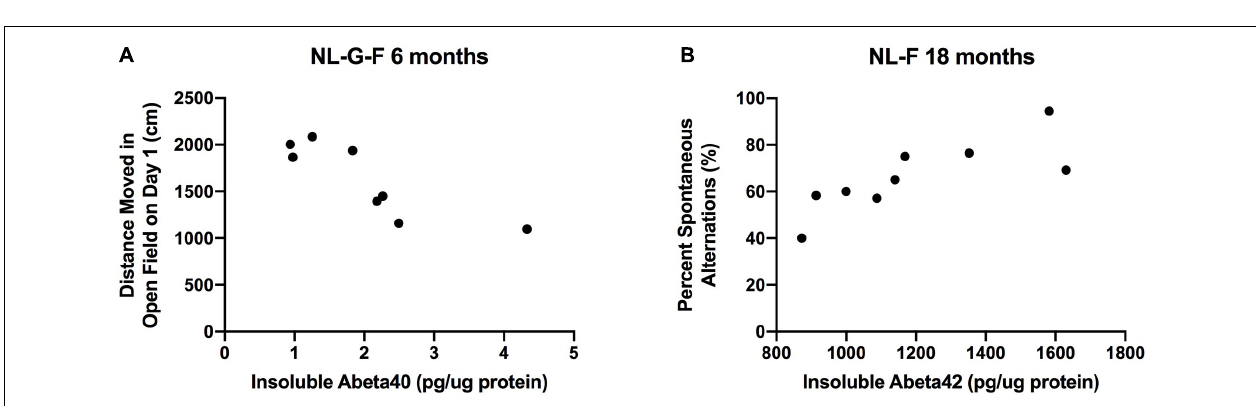
FIGURE 15 | (A) At 6 months of age, insoluble cortical A β levels were negatively correlated with activity levels on the first day of open field testing ( r = –0.8494, p = 0.0076, n = 8 XY pairs). (B) At 18 months of age, insoluble cortical A β 42 levels were positively correlated with percent spontaneous alternation in the Y maze ( r = 0.7943, p = 0.0106, n = 9 XY